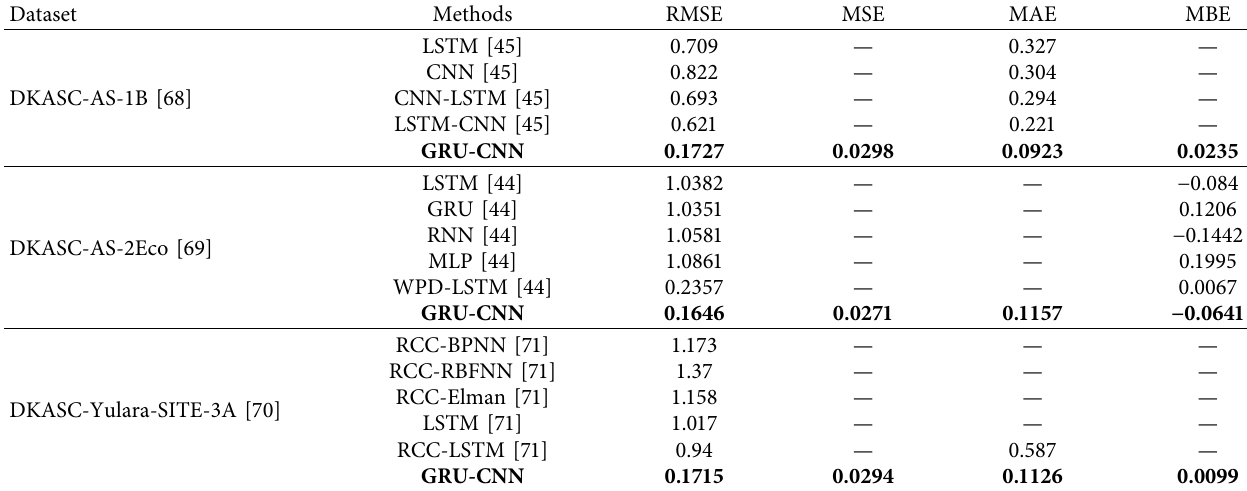
Figure 4: Visual representation of the proposed hybrid GRU-CNN forecasting model. (a) DKASC-AS-1A dataset, (b) DKASC-AS-1B dataset, (c) DKASC-AS-2Eco, and (d) DKASC-Yulara-SITE-3A datasets actual and forecasting values. Table 5: The performance of the proposed model is compared with an existing state-of-the-art model for PV power forecasting. The best performance is shown in